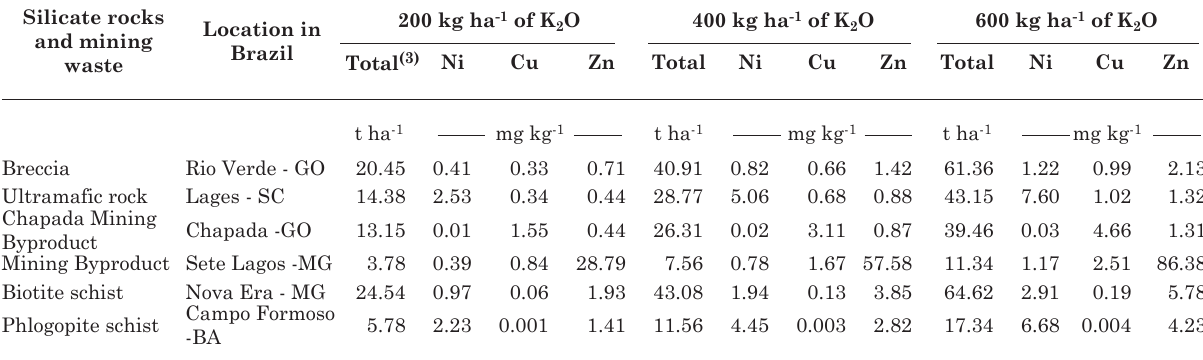
table 3. origin (1) of ground rocks and mining wastes with respective rate and available trace-elements (2)